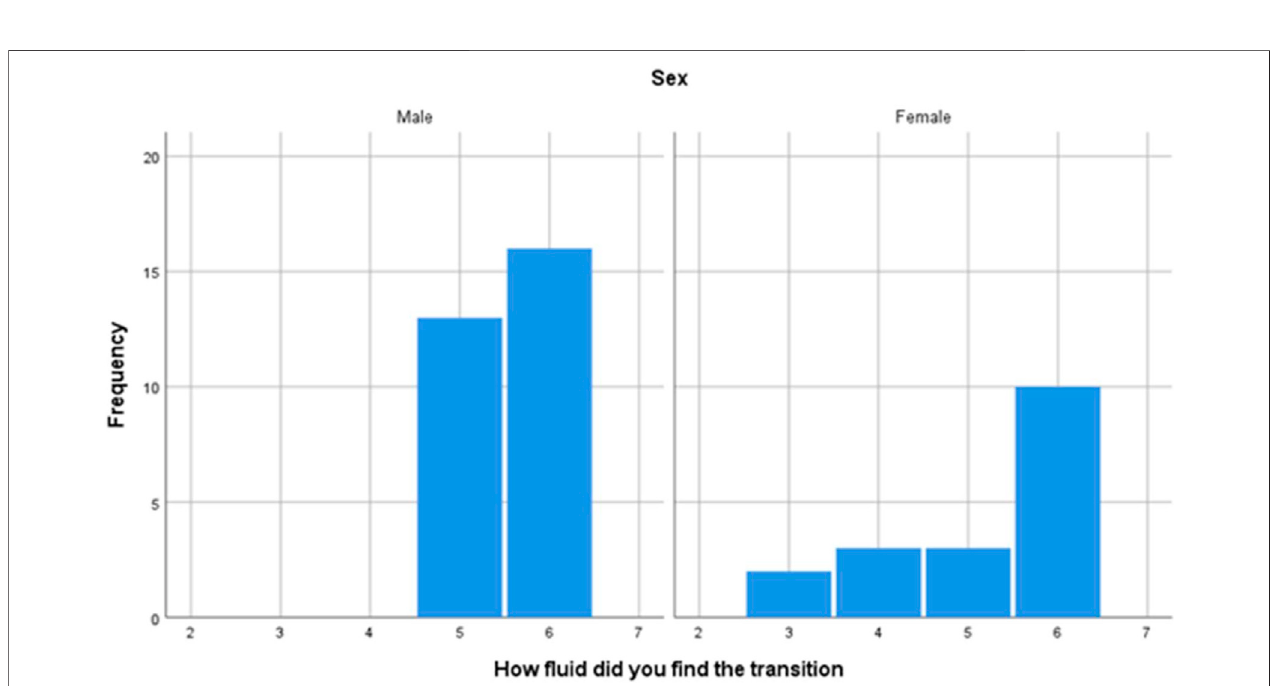
FIGURE 15 | Questionnaire participants results for how fl uid the transition between entering and exiting the minigame is.